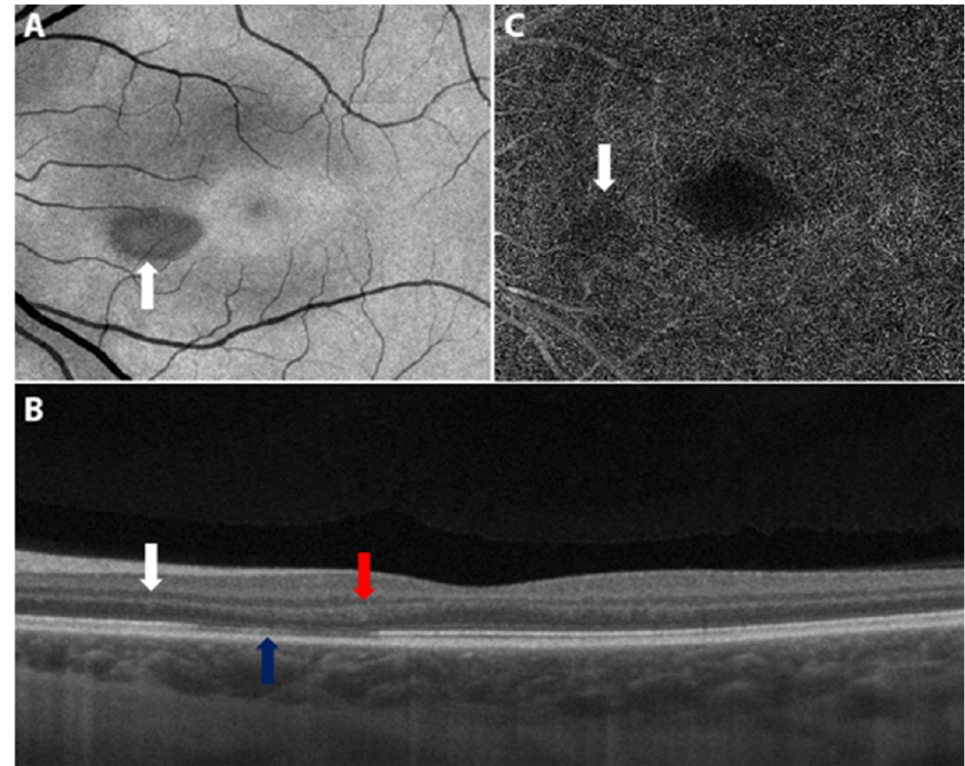
Figure 4. Swept source optical coherence tomography of the left macula. ( A ) The en face image displays a teardrop-shaped macular lesion (white arrow) nasally to the fovea. ( B ) The cross-sectional image displays slight hyperreflectivity of the outer nuclear (white arrow) and plexiform (red arrow) layers and disruption of the ellipsoid zone (blue arrow) corresponding to the lesion. ( C ) The angiogram indicates subtle dropout (white arrow) in the deep capillary plexus corresponding to the lesion. Adapted from Bøhler, A.D.; Strøm, M.E.; Sandvig, K.U.; et al. Acute macular neuroretinopathy following COVID-19 vaccination. Eye (2021). https://doi.org/10.1038/s41433-021-01610-1 [87]. Figure 2, Copyright (2021) with permission from Springer Nature, open access article under the terms of the Creative Commons Attribution